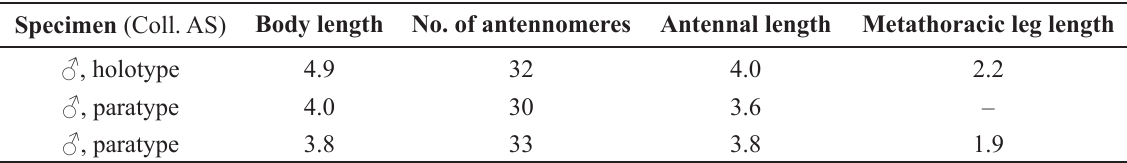
Table 9. Plusiocampa (Plusiocampa) rhea Sendra sp. nov. Length of the body, antennae and metathoracic legs (measurements in mm), in addition to the number of